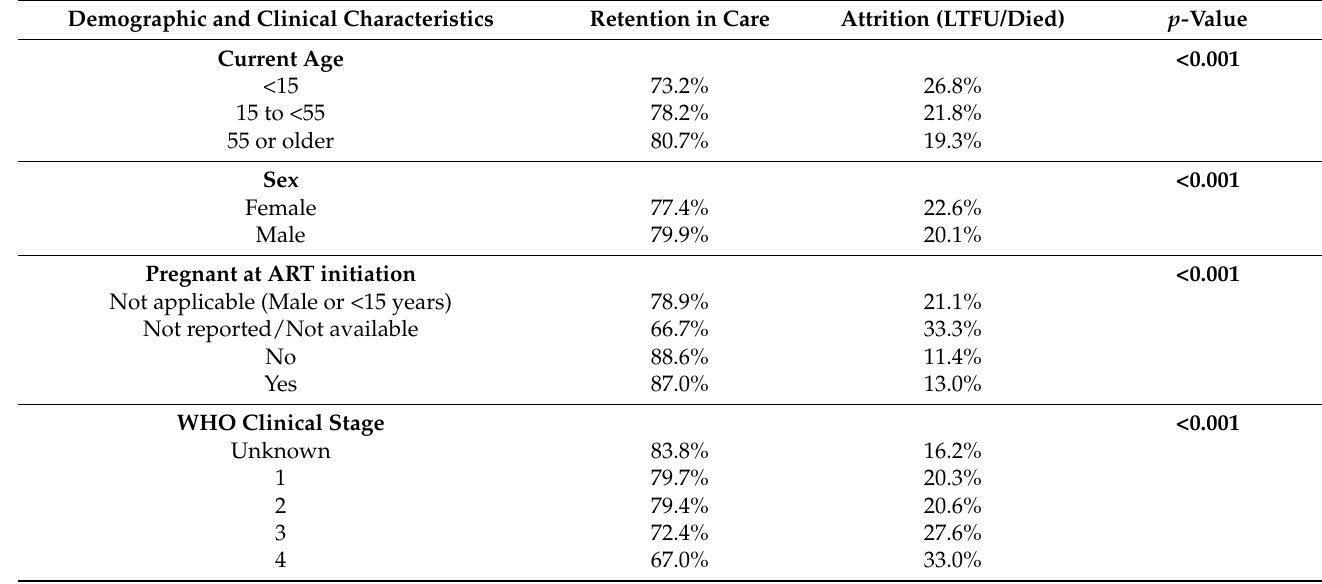
Table 2. Variation in retention for persons living with HIV by patients’ demographic and clinical